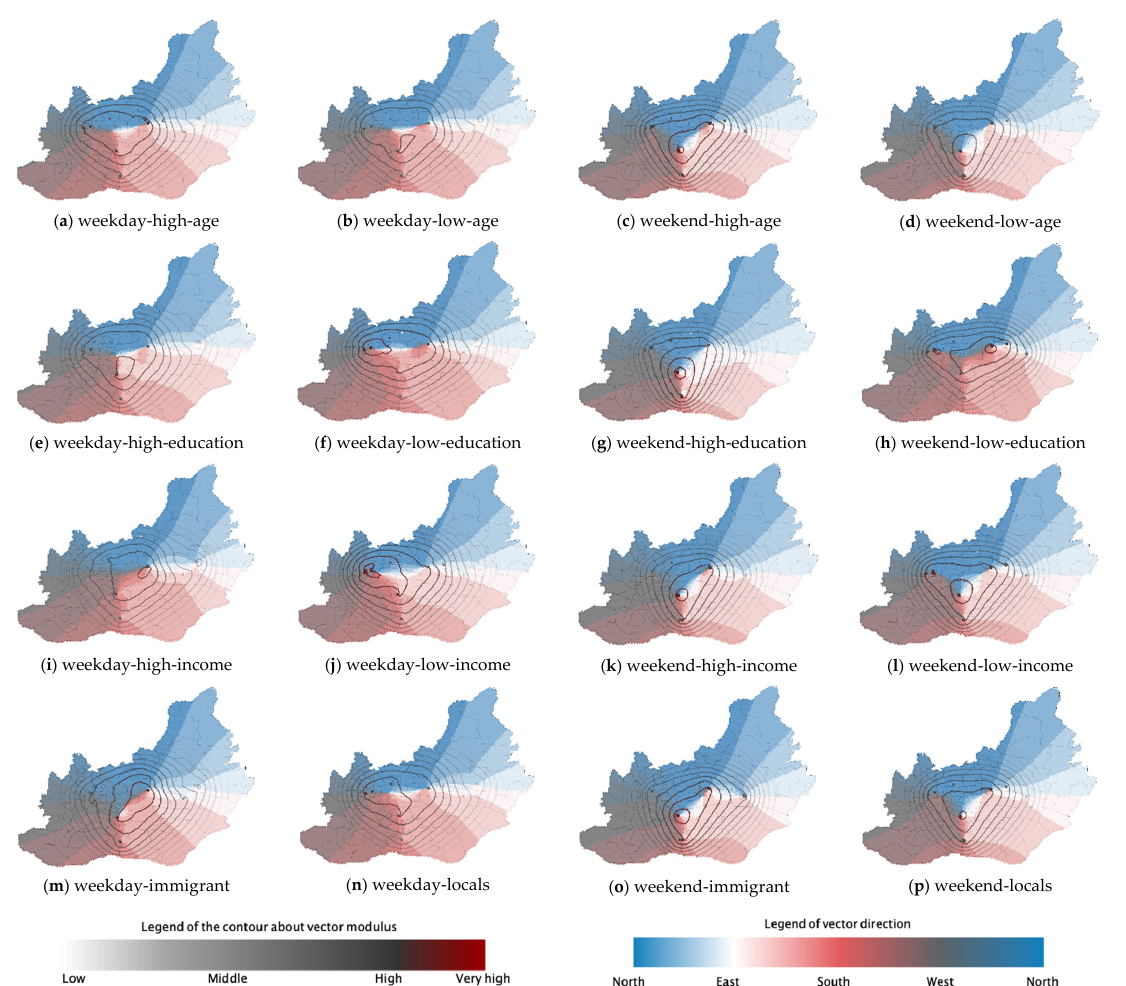
Figure 12. Travel-demand vector field for social groups on weekdays and weekends.